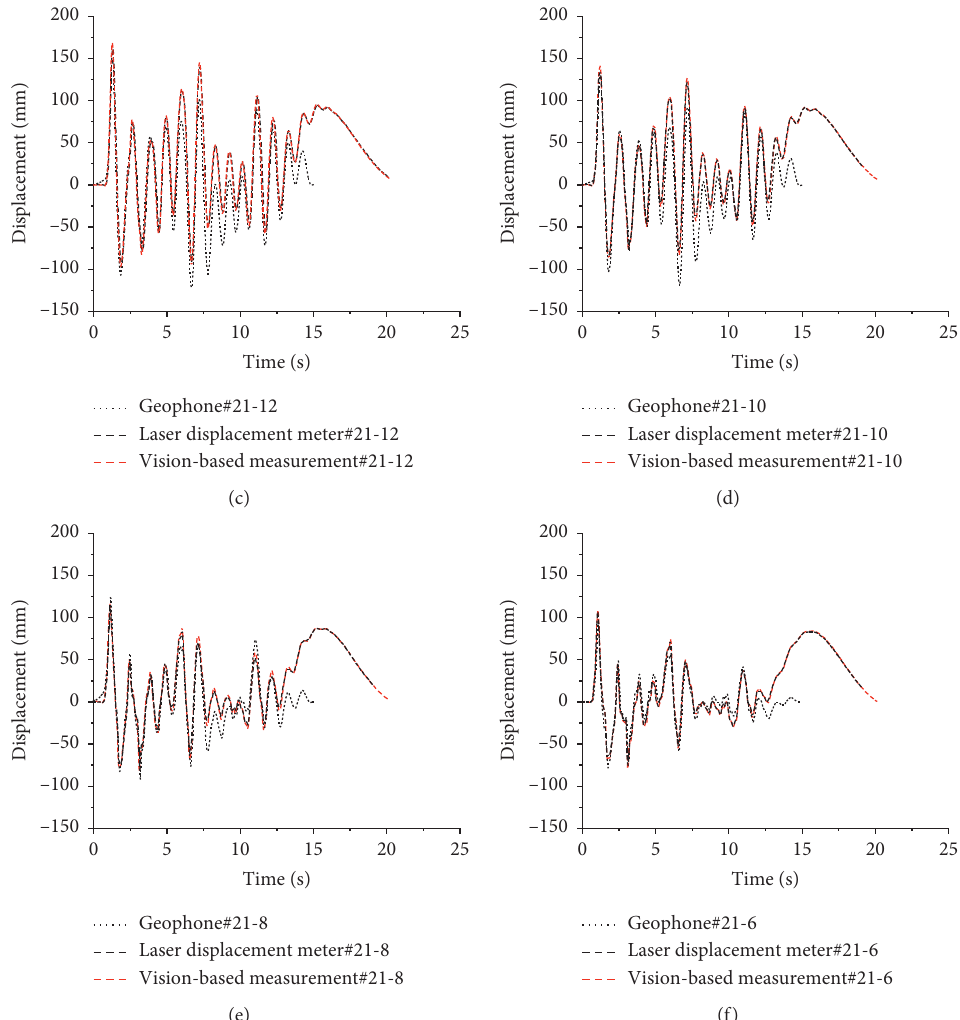
Figure 10: Working condition 21. (a) Fifteenth floor. (b) Fourteenth floor. (c) Twelfth floor. (d) Tenth floor. (e) Eighth floor. (f) Sixth